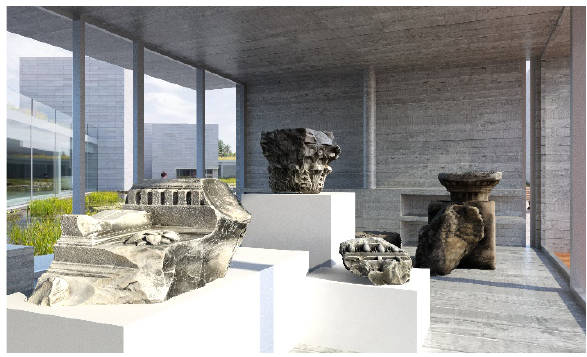
Figure 7: Proposal to musealize the reconstructed pieces in a newly designed museum project. In the event that the choice of the container containing the freely move in the digital space. The three-dimensional model